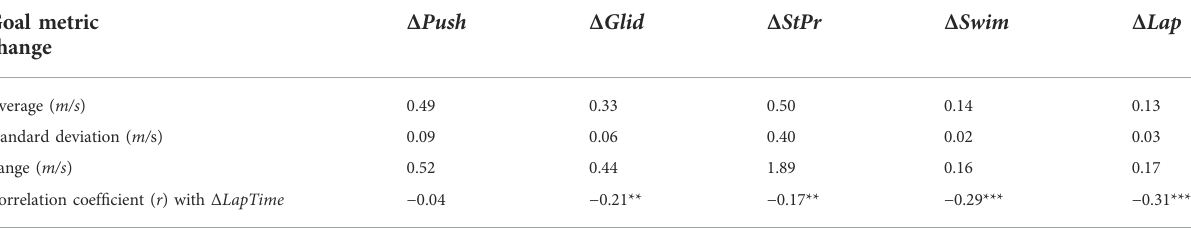
TABLE 3 Average, standard deviation, and range of each goal metric change and its correlation coef fi cient ( r ) with Δ LapTime for all meaningful progress comparisons. The change values that are below RMSE of each goal metric are removed. Goal metric